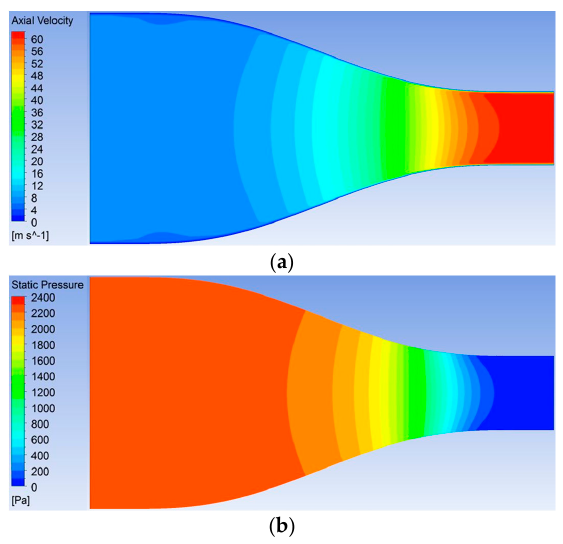
Figure 5. Calculated ( a ) axial velocity and ( b ) static pressure contours for the case with CT #1 having circle cross-sectional shape and V ex = 60 m/s. Table 3. Pressure drops along investigated contractions (V ex = 60 m/s).